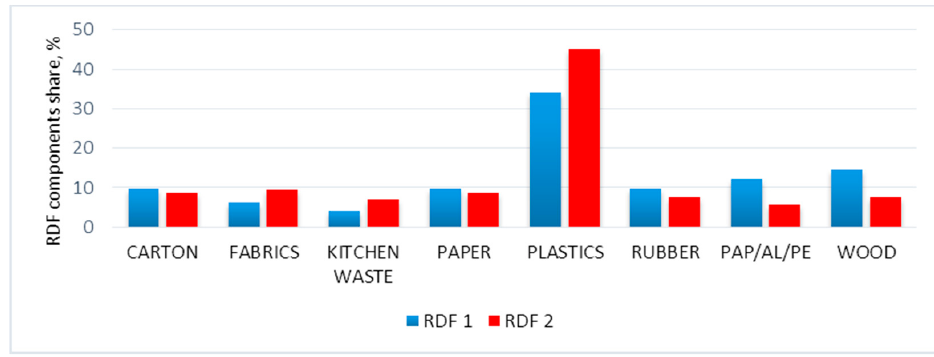
Figure 2. Percentage of individual major waste groups in refuse-derived fuel (RDF) 1 and RDF 2 [58].